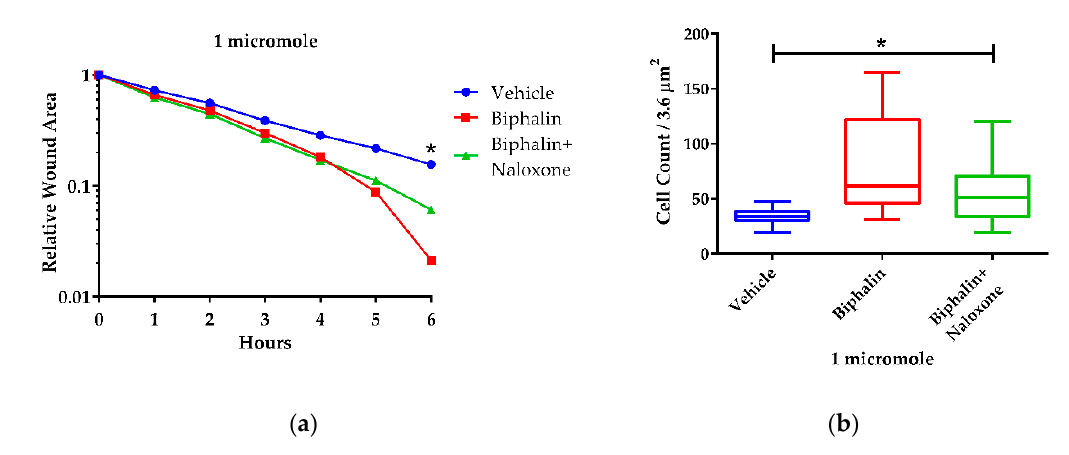
Figure 1. ( a ) Effect of biphalin and biphalin plus naloxone at 1 and 10 µM concentrations on wound healing rate (RWA) in in vitro wound healing model. At 1 µM concentration, biphalin treatment (0.21 ± 0.23) has statically significant positive effect on HCECs compared to vehicle (0.155 ± 0.169) and biphalin plus naloxone (0.061 ± 0.063) groups ( n = 8, * p < 0.05). ( b ) Effects of biphalin and biphalin plus naloxone on the movement of corneal epithelial cells in the transwell migration assay. Both graphs show the average number of migrated cells in ten different micrograph area (3.6 µM 2 ) in two independent experiments. At 1 µM concentration, biphalin treatment (82.35 ± 42.96) has statically significant positive effect on HCECs compared to vehicle (34.35 ± 7.08) and biphalin plus naloxone (52.75 ± 23.76) groups ( n = 20, * p <